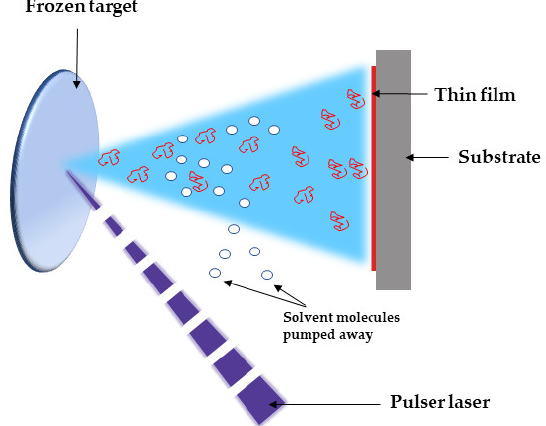
Figure 2. Simplified schematic of the MAPLE process.